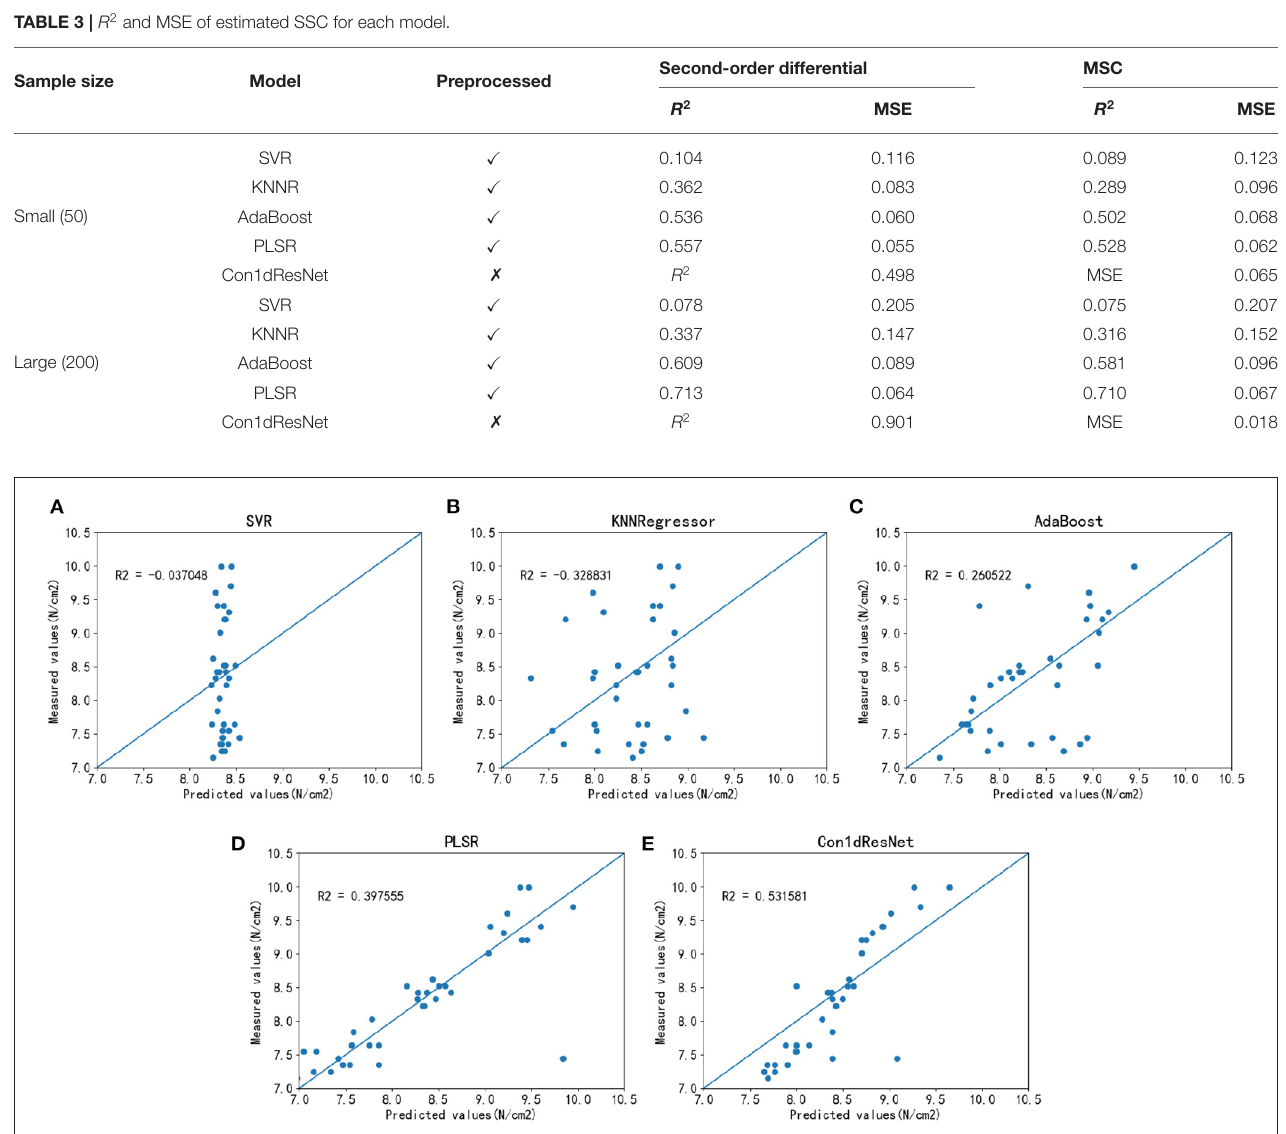
FIGURE 7 | Estimation results of firmness for each model on a large sample dataset. (A) SVR estimation results on large sample data. (B) KNNR estimation results on large sample data. (C) AdaBoostR estimation results on large sample data. (D) PLSR estimation results on large sample data. (E) Con1dResNet estimation results on large sample